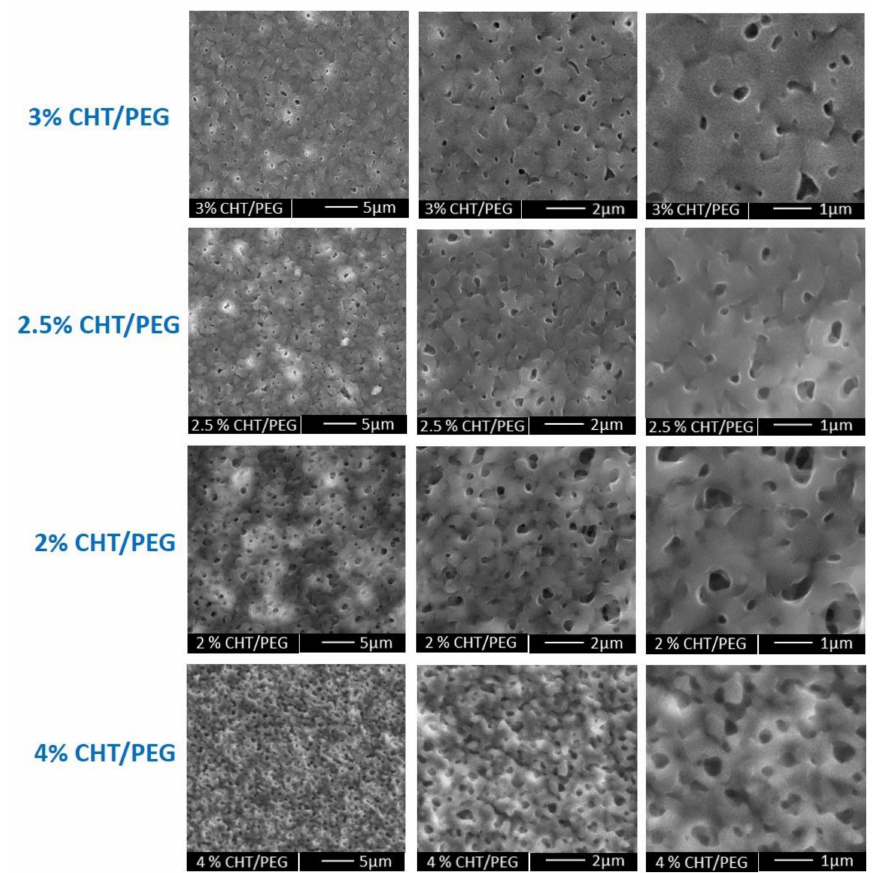
Figure 2. SEM pictures at different magnification of microporous membranes obtained by casting polymeric solution with different (wt/v) % of CHT/PEG, as reported in Table 1.